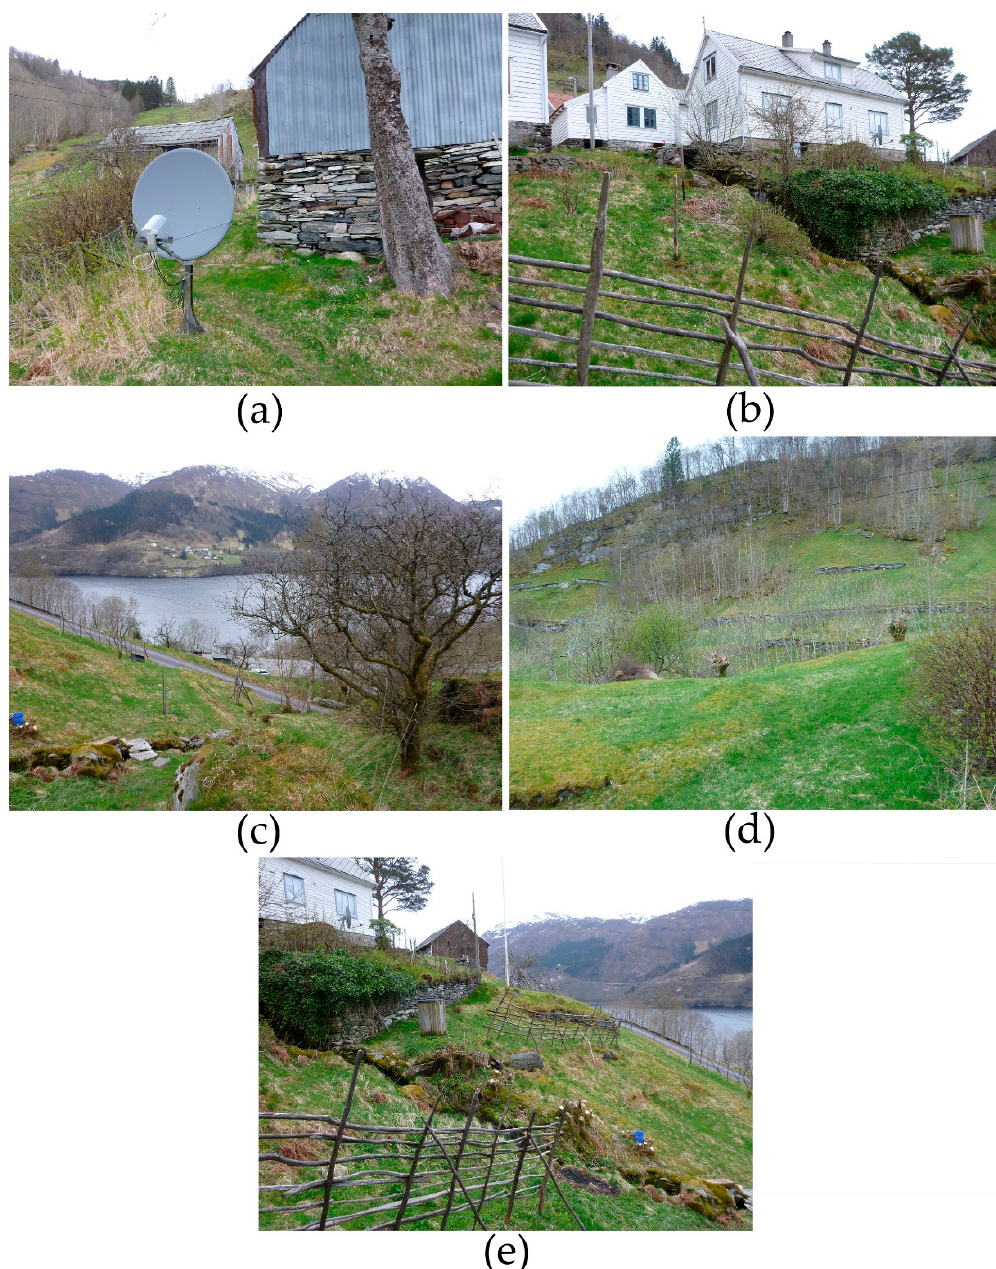
Figure 4. Photographs taken from a pre-defined (quantitative) photo-point towards north ( a ), east ( b ), south ( c ), west ( d ), and in a freely chosen direction, southeast ( e ). Views include buildings, terrace walls and other valued landscape elements. Photos: Frode Bentzen / NIBIO.